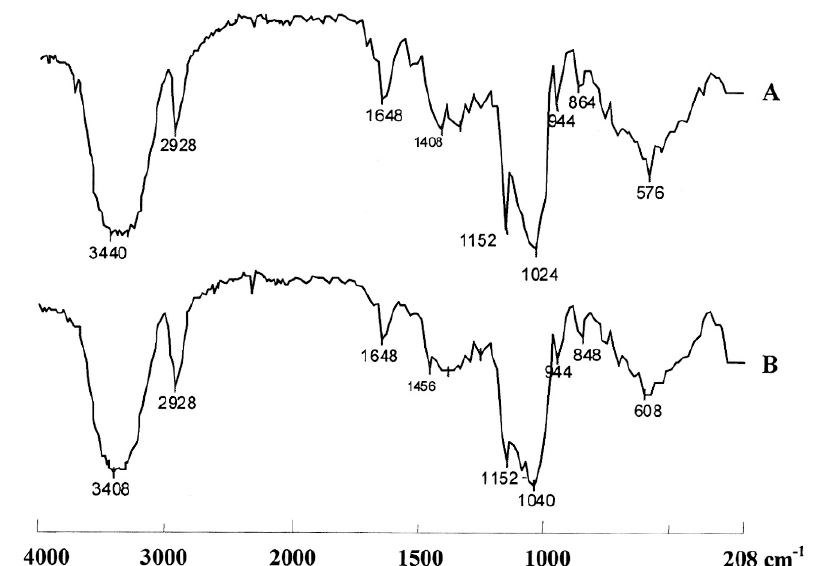
Figure 6. IR spectra of β -cyclodextrin (A) and 2-hydroxypropyl- β -cyclodextrin (B).